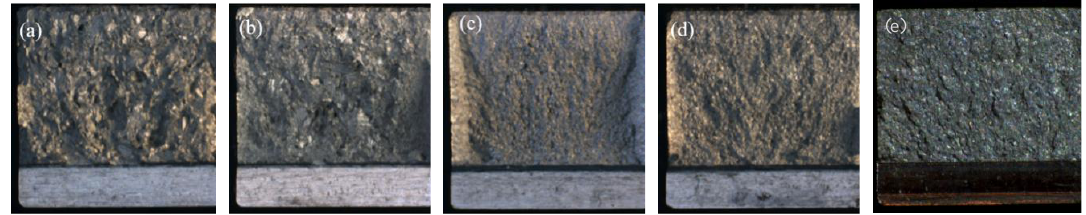
Figure 3. Fracture appearance of broken impact specimens: ( a ) 1200 °C/30 min, FC, 730 °C/2 h; ( b ) 1065 °C/1 h, FC, 730 °C/2 h; ( c ) 955 °C/1 h, FC; ( d ) 925 °C/4 h, CFC@50 °C/h to 760 °C, FC; ( e ) as-extruded.